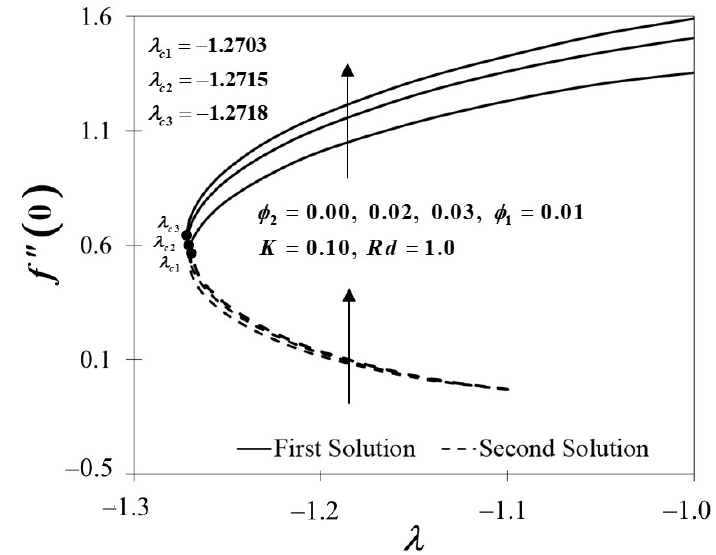
Figure 4. Figure 4. Towards λ by assorted φ 2 . Figure 4.